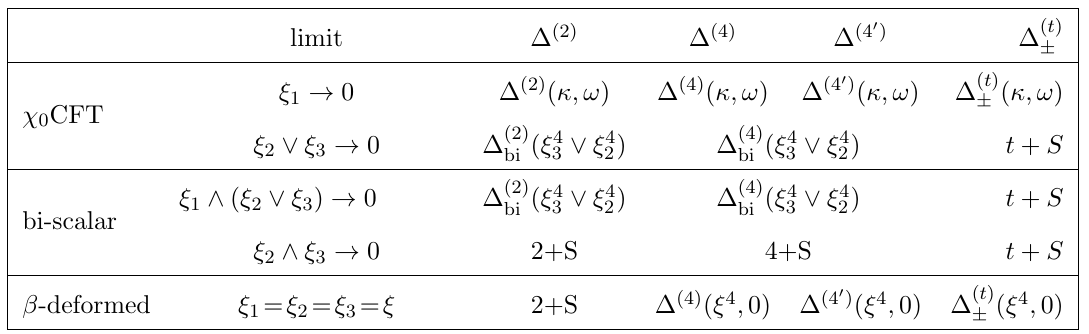
Table 2 . In this table we summarize the operator and dimension content of exchange operators in three reductions of (cid:31)